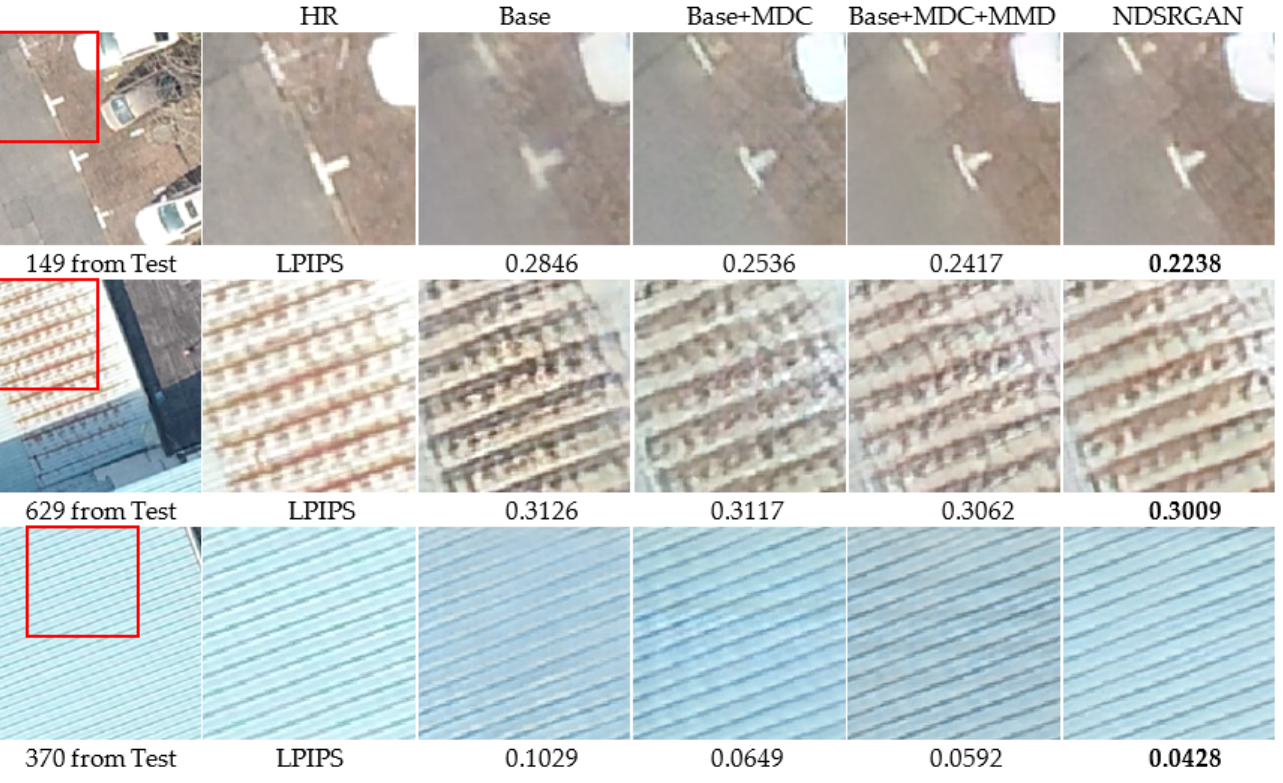
Figure A1. Reconstructed images of the ablation experiment and their corresponding LPIPS values. The best performance in bold.